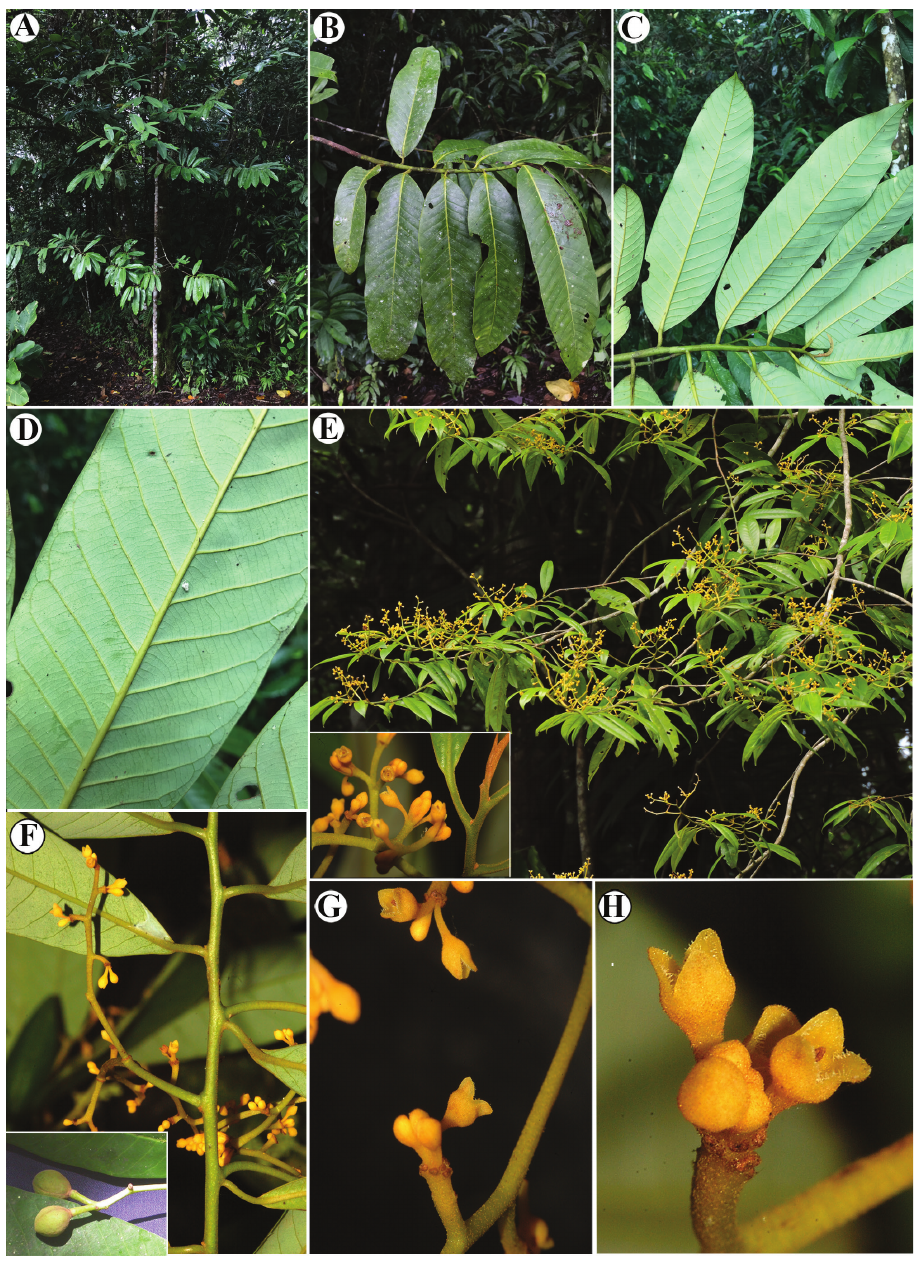
Figure 22. Virola montana A juvenile tree showing branching pattern B leaf blades on adaxial side C leaf blades on abaxial side D venation. Virola multiflora . E Branch with staminate inflorescences, inset show- ing twig and flowers F twig, leaf blade on abaxial surface and inflorescences, inset showing immature fruit G lateral view of a perianth H close-up of staminate flowers. Photos by J. Esteban Jiménez ( A–D ); B. Hammel ( E–H ), Indiana Coronado ( F ,